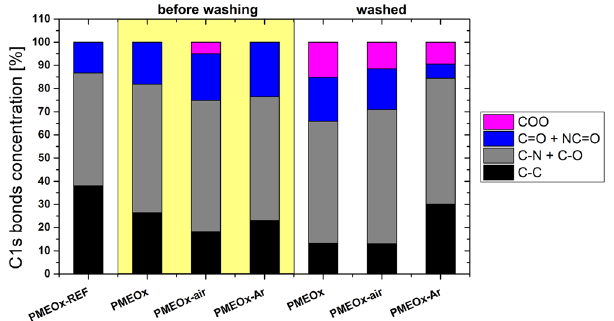
Figure 6. Relative concentrations of particular chemical bonds from high-resolution C1s spectra. Comparison of chemical composition of non-treated (PMEOx) and plasma treated (PMEOx-air, PMEOx-Ar) layer before and after washing to